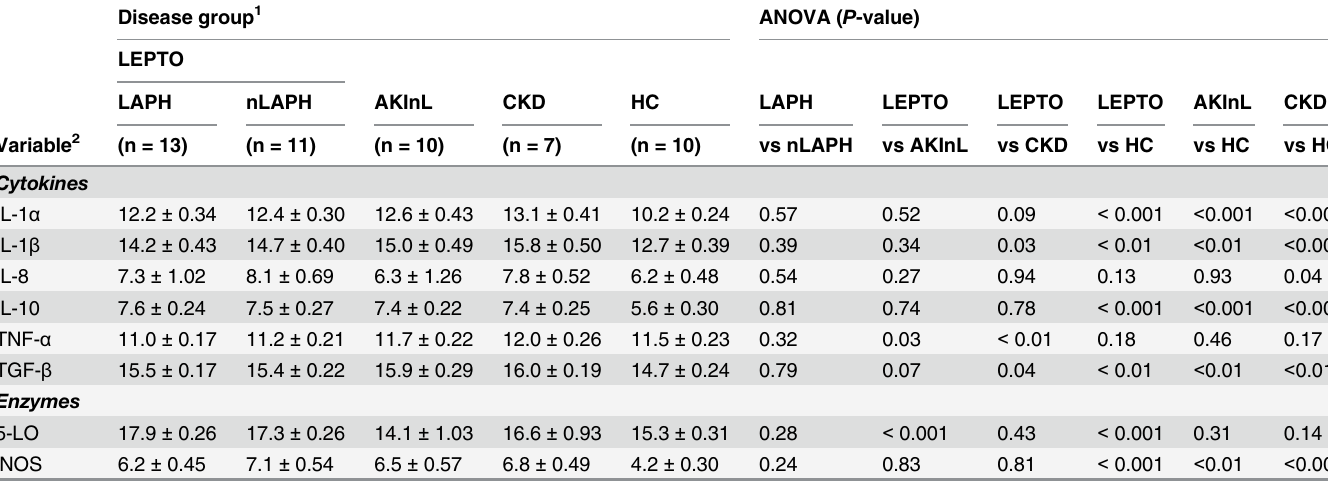
Table 3. Mean ± SEM area under the curve of relative mRNA expression (CT, log 2 ) of genes encoding cytokines and enzymes in whole blood of dis- eased dogs during the first three days after admission to the clinic (non-survivors excluded). Disease group